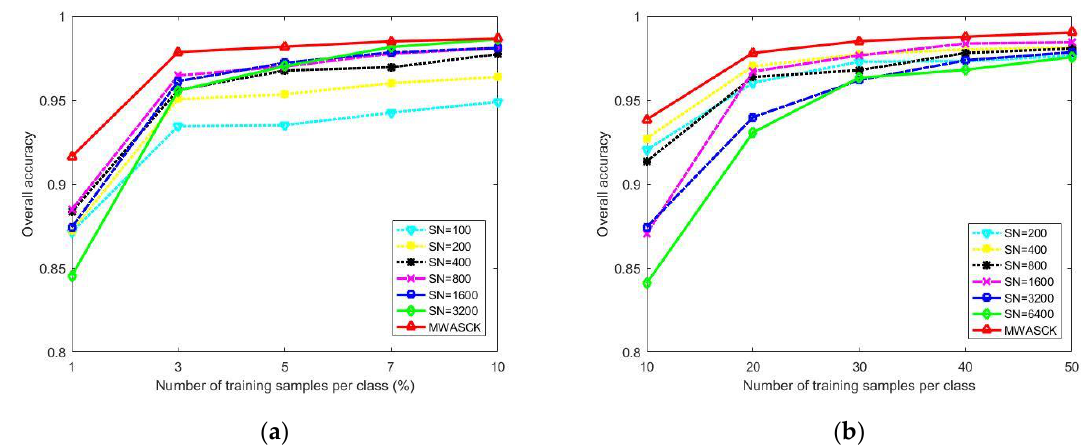
Figure 6. OA values of single-scale and multi-scale MWASCK under different training samples. ( a ) Indian Pines; ( b ) University of Pavia.